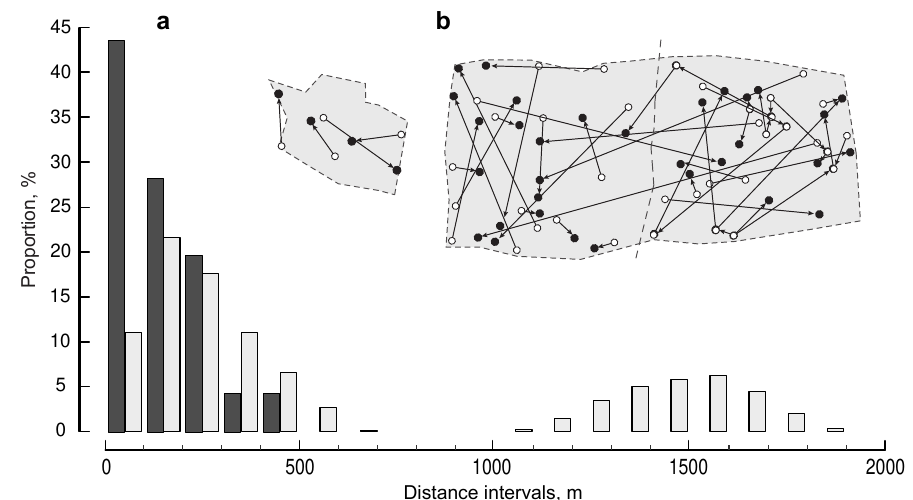
Figure 4. Occurrences of distances between nests of extra-pair mates ( a ) and the location of nests of extra-pair mates ( b ). In ( a ), the black bars indicate the distribution of distances between the nests of extra-pair mates, and the light bars depict the distribution of all possible distances between all nests. ( b ) Nests of extra-pair males (open circles) and extra-pair females (filled circles). The arrows mark the distance from the nest of the extra-pair male to the respective nest of the extra-pair female. Space between the plots is reduced. For the actual location of the areas, see Figure 1.